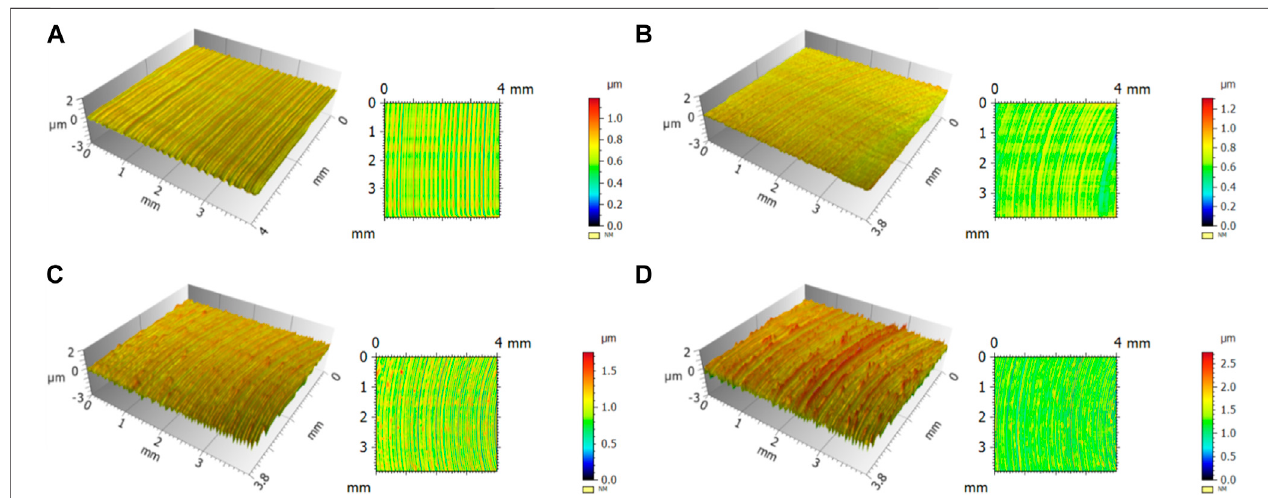
Frontiers in Mechanical Engineering |